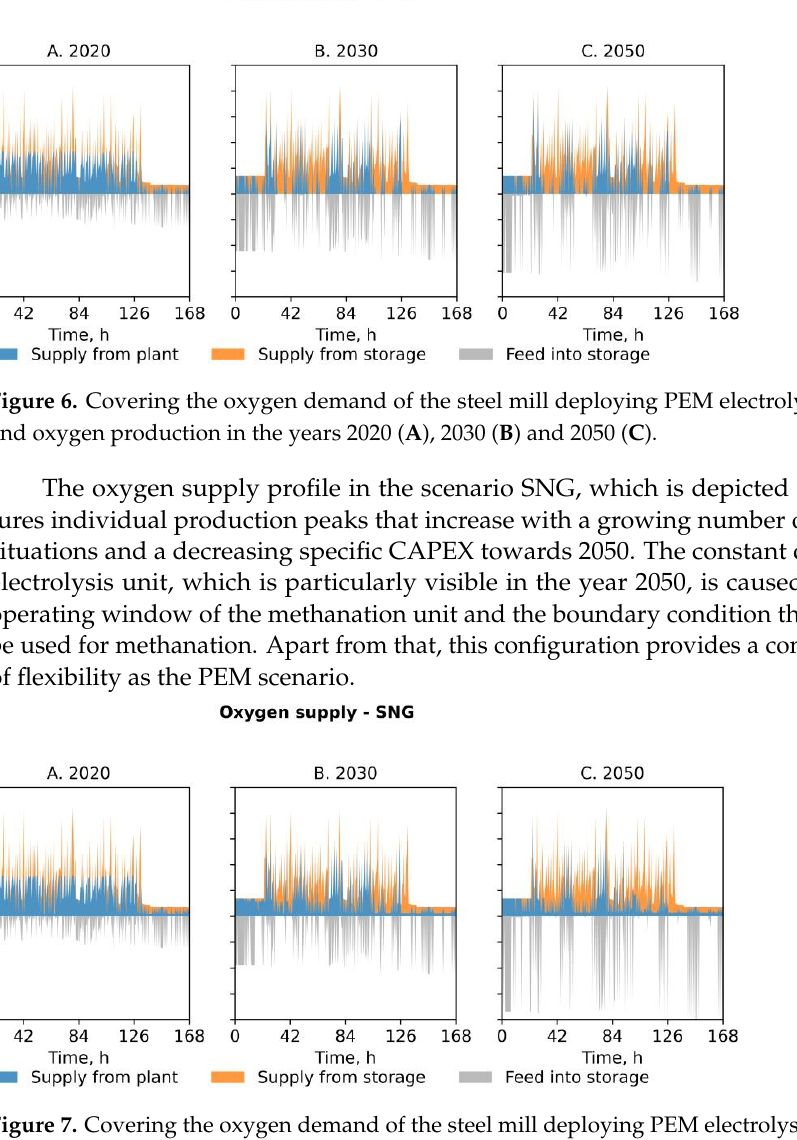
hydrogen and a subsequent methanation unit for SNG production in the years 2020 ( A ), 2030 ( B ) and 2050 ( C ).